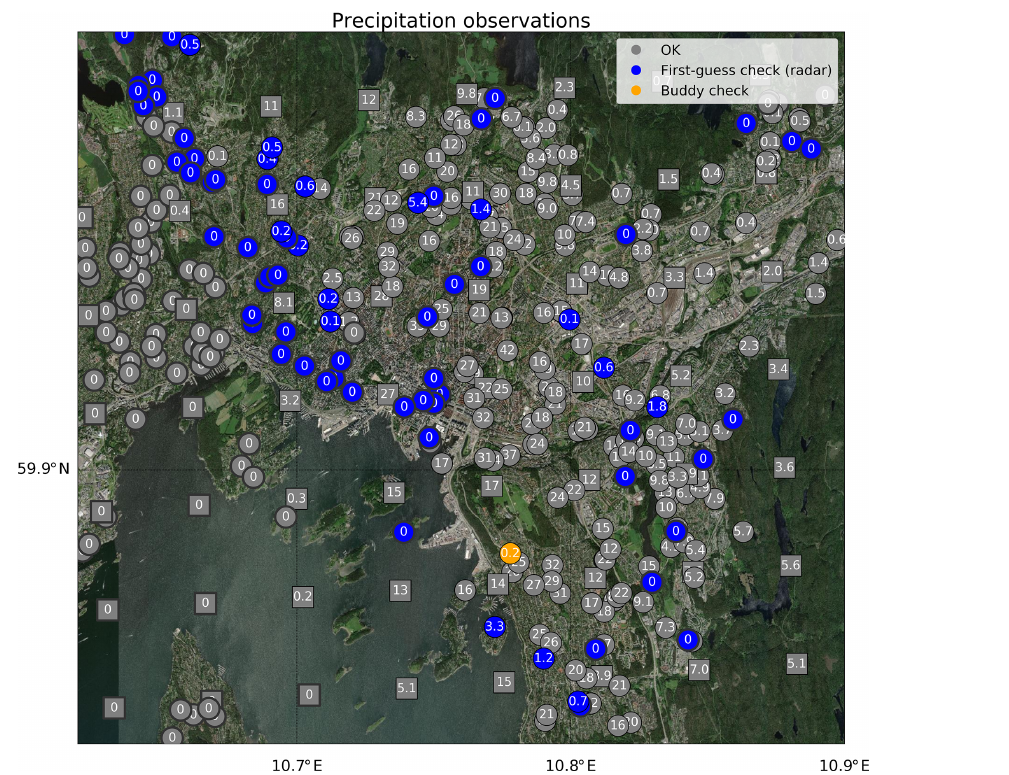
Figure 4. The result of the quality control by Titan for precipitation observations in Oslo for 00:00UTC on 4 August 2019. The values are total accumulated precipitation over the last hour. The observations (circles) passing the quality control are shown in grey, whereas those failing the buddy check or the first-guess check (radar) are shown in orange and blue, respectively. The radar data are shown as a grid of grey squares. Background image source: ESRI World